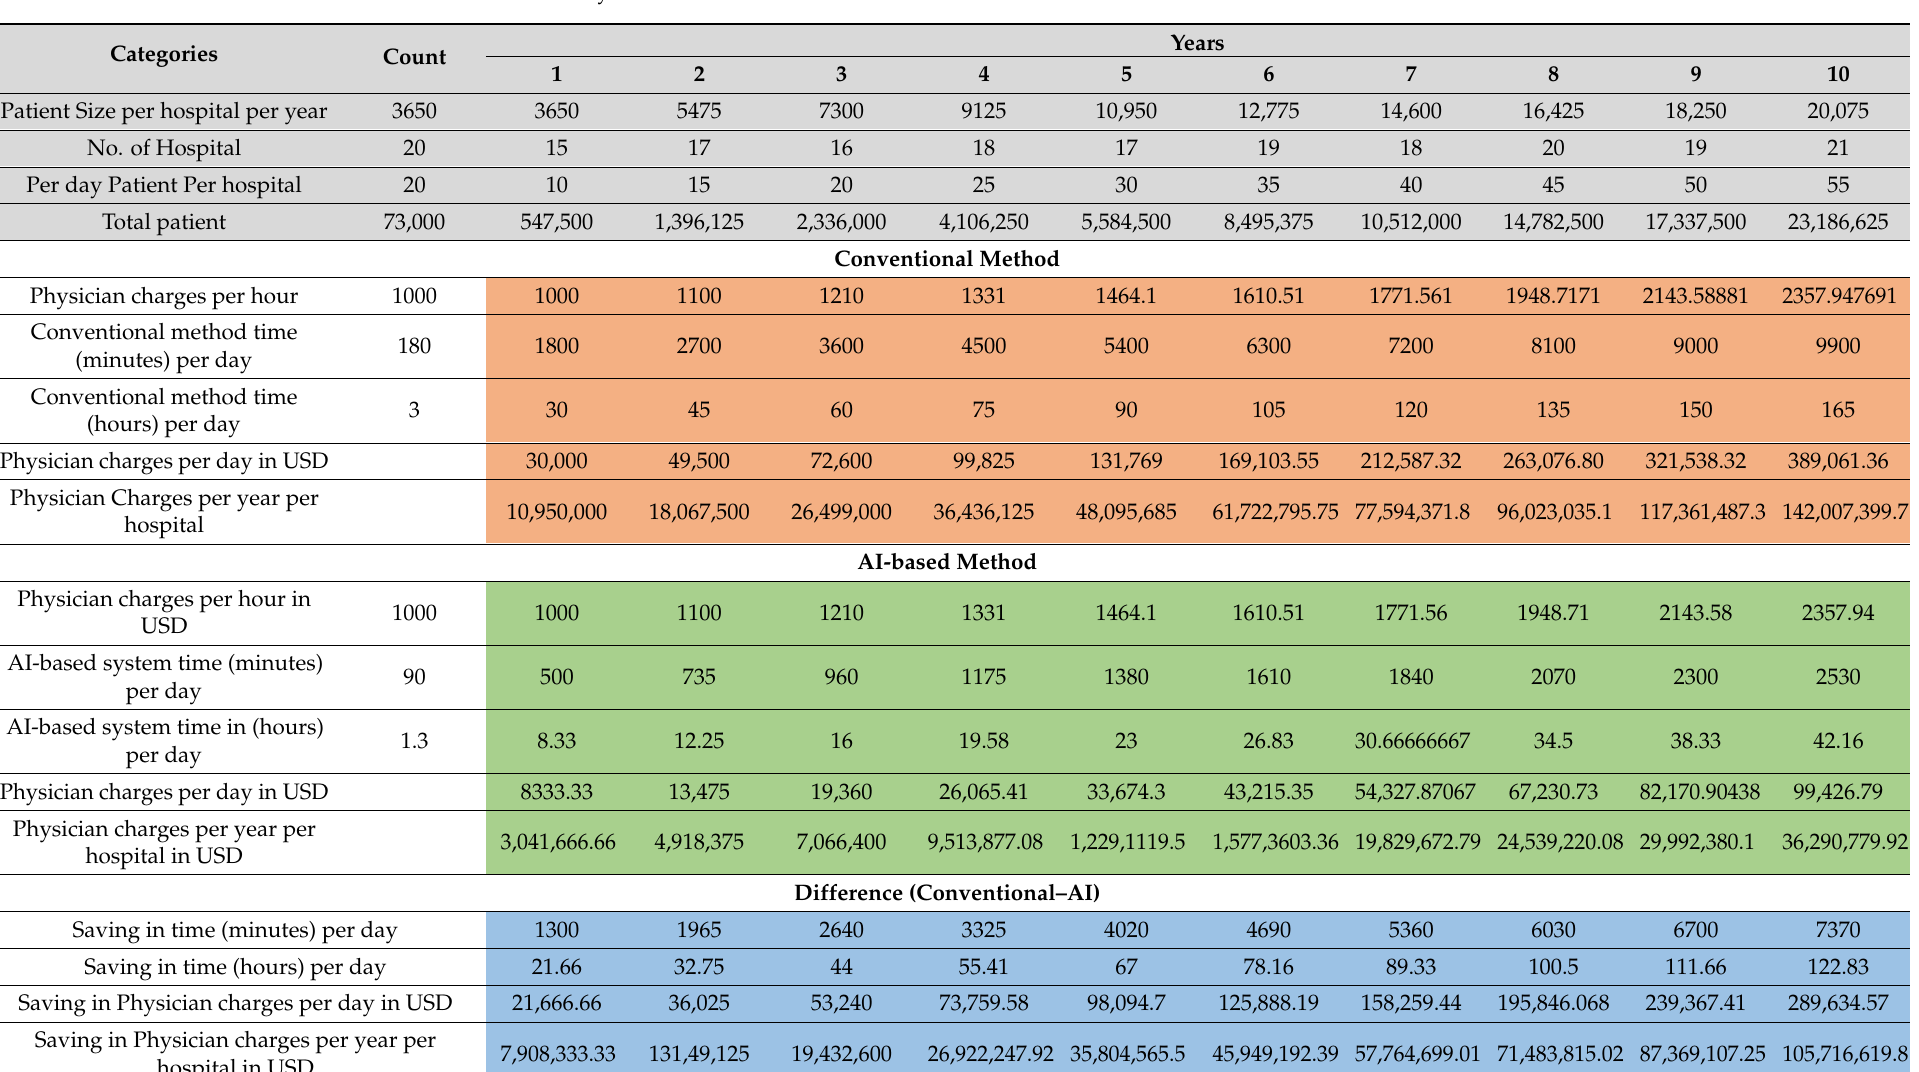
Table A2. Cost Effective analysis for the